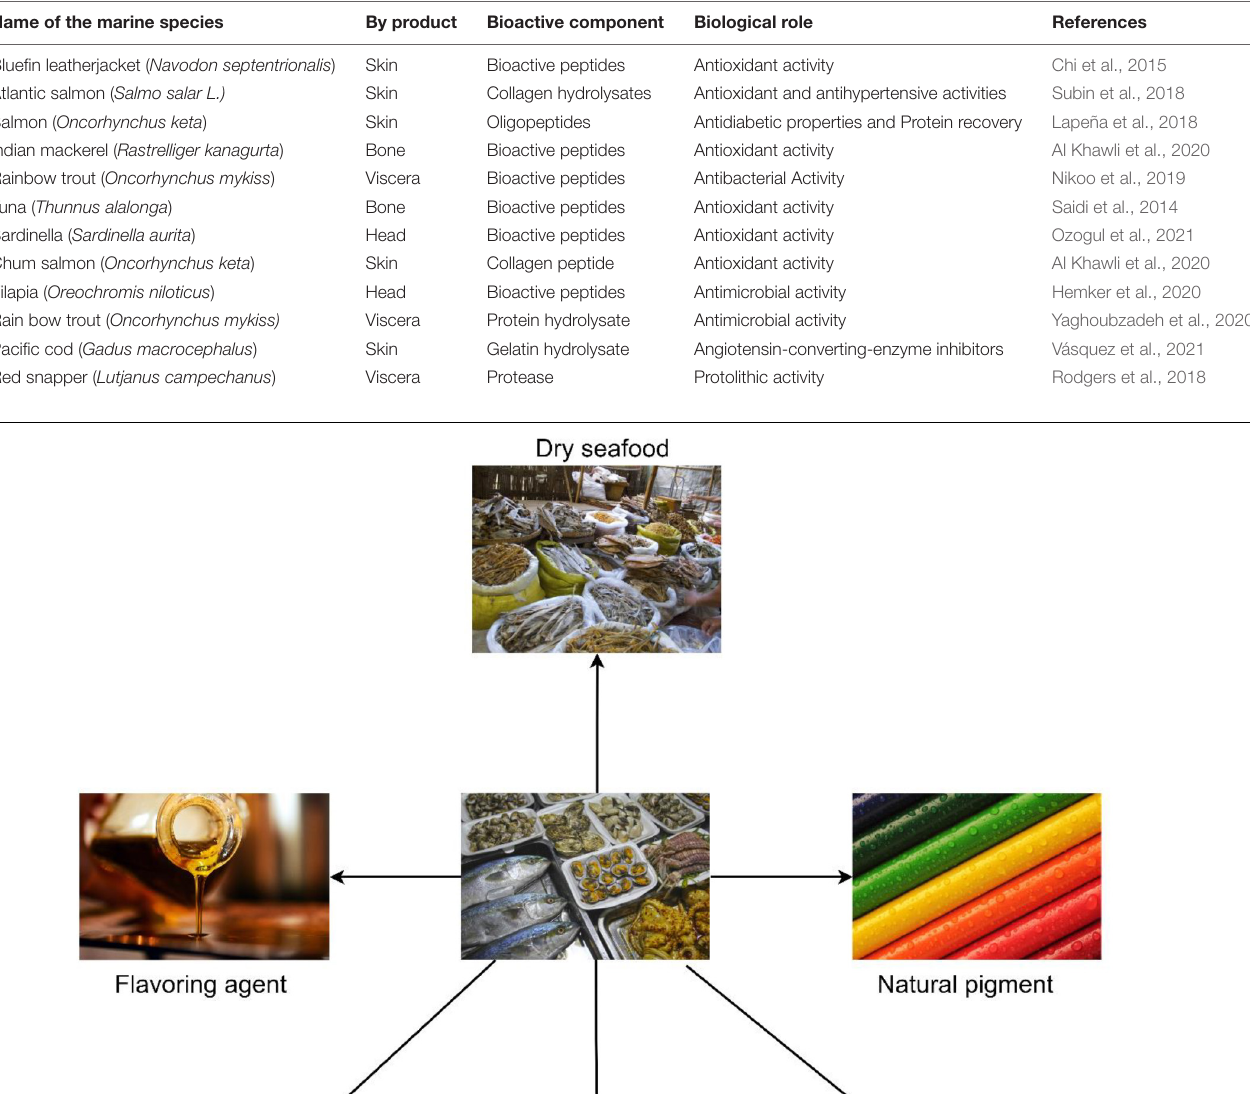
Due to its cellulose structure, the cell wall of microalgae is usually tough to digest, inhibiting protein absorption when consumed. Microalgae protein hydrolysates